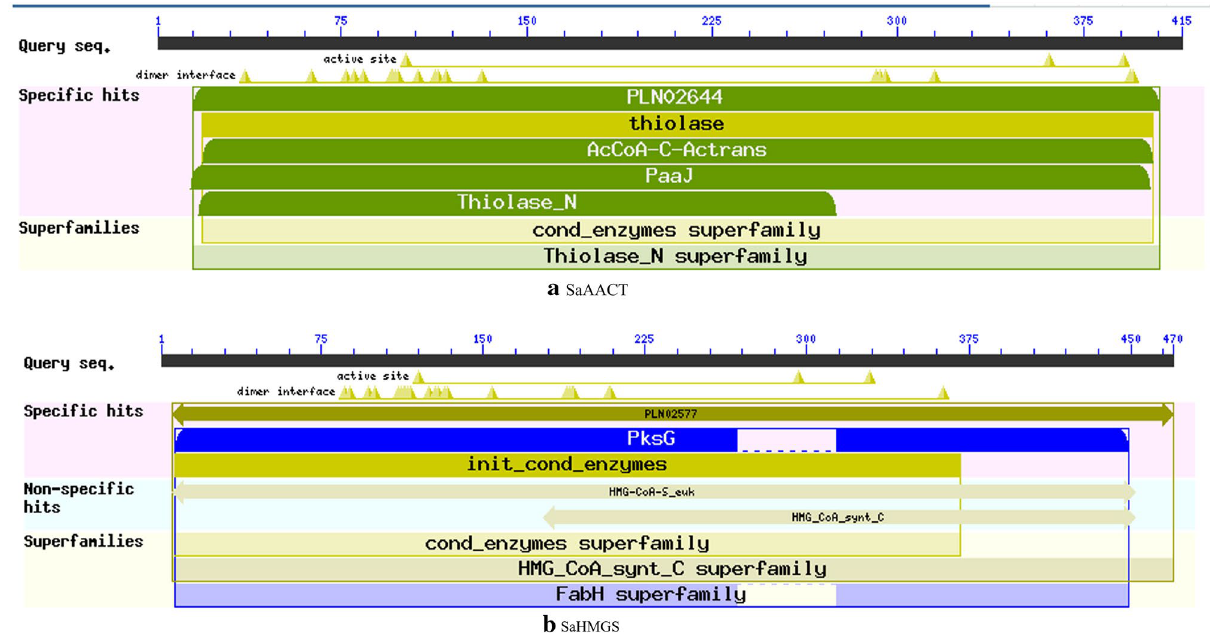
Figure 2. Conserved domain of SaAACT ( a ) and SaHMGS ( b ) in S. album . Which was predicted by the Conserved Domains database in NCBI using my own gene